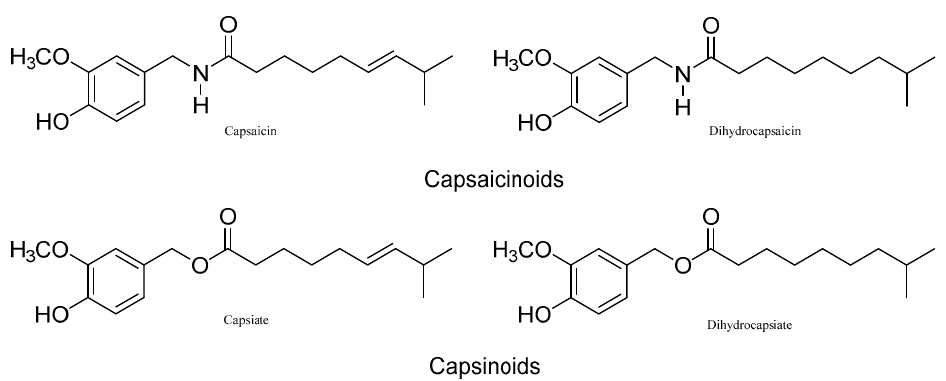
Figure 1. Chemical structures of major capsaicinoids and capsinoids.